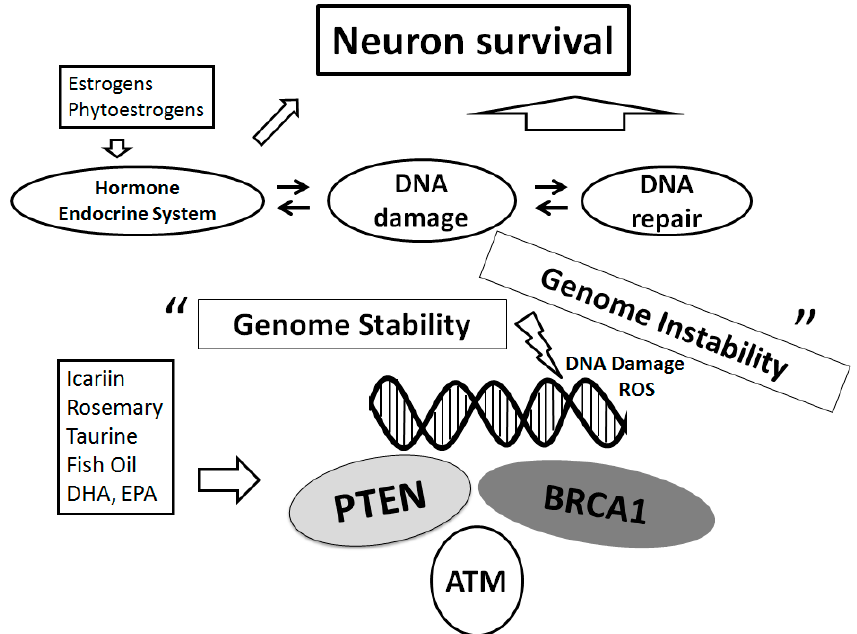
Figure 3. Schematic representation of the DNA repair system for neuroprotection implying that genome stability is sustained on several tumor suppressors. Examples of the action known to act on the neuron survival pathways are shown. Several dietary modulators linked to this pathway are also demonstrated, whose potential molecular targets may be based on the predominant sites. Note that some critical functions have been omitted for clarity.